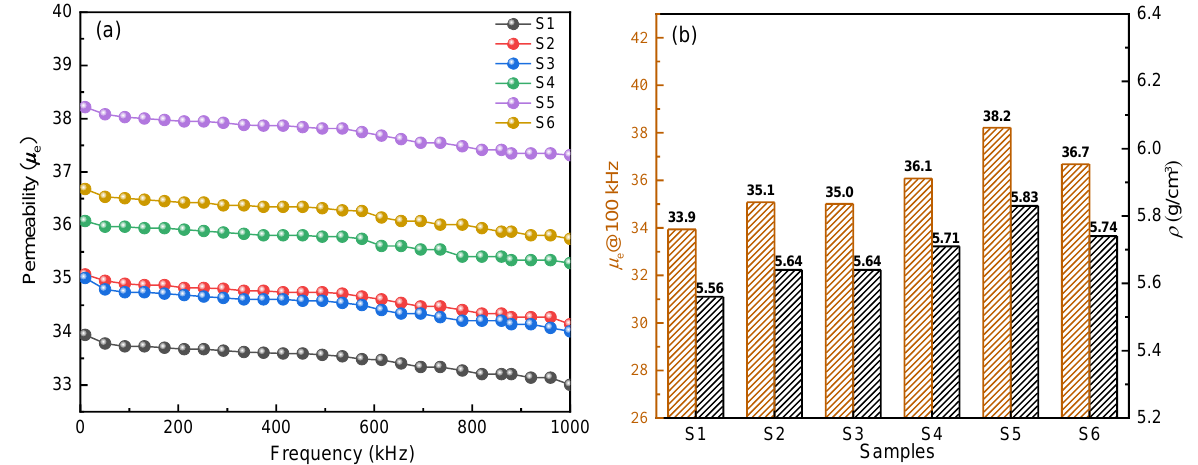
Figure 6. ( a ) Variations in the effective permeability with frequency for S1~S6; ( b ) μ e @100 kHz and density for S1~S6.